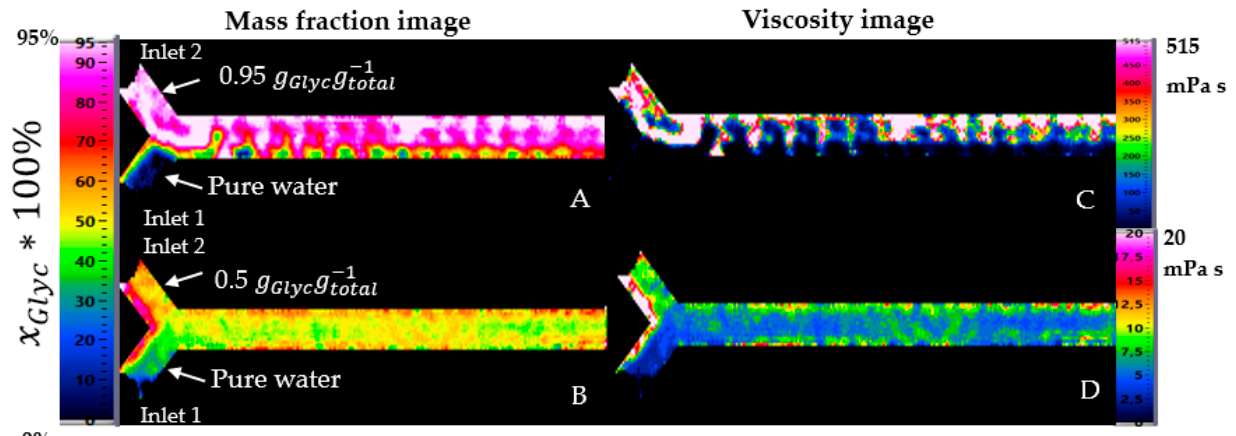
Figure 9. Concentration in mass fraction and viscosity profile in the channel. The viscosity is calculated by using the local concentration in mass fraction and Equation (1). ( A ) local concentration in mass fraction at significant viscosity difference, ( B ) local concentration at small viscosity difference ( C ) calculated local viscosity from A and ( D ) calculated local viscosity from B.